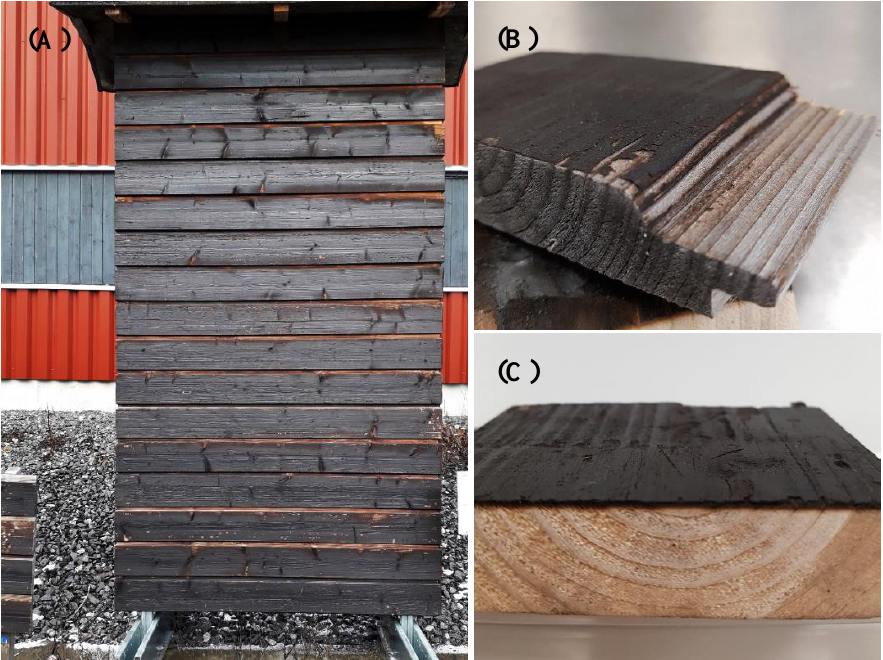
Figure 4. ( A ) The wall in January 2020, 2 years into weathering experiment. The examined panel is situated highest in the left corner; ( B ) detail of the tongue of the panel; ( C ) surface on a cut-out of the same panel showing intact, well-preserved char layer and underlying, unmodified wood.